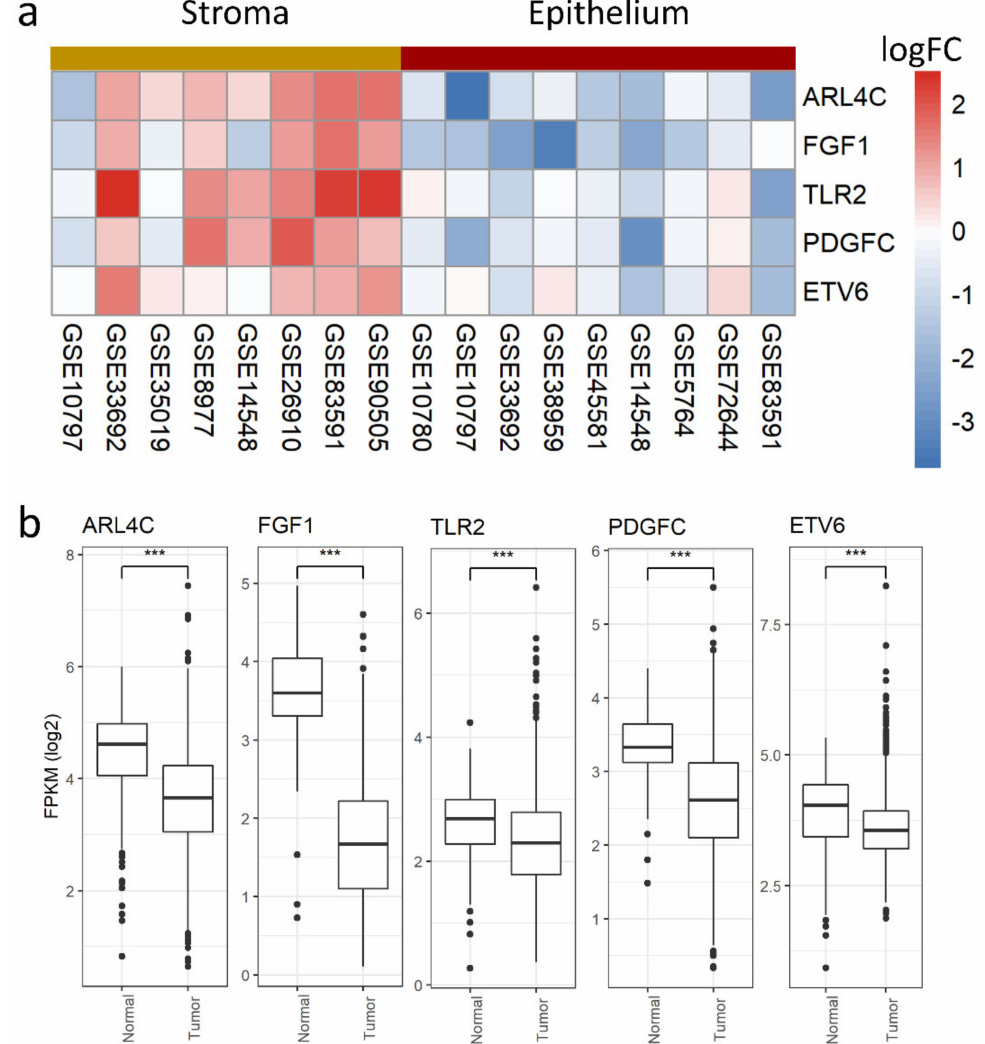
Figure 4. The opposite regulation of genes in tumor stroma or epithelium is hidden in bulk samples. ( a ) Top five significantly differentially expressed genes with higher expression in tumor stroma and lower expression in tumor epithelium when compared to respective compartments in normal breast tissue. Rows correspond to the five selected genes and columns to GEO IDs of datasets where the comparisons were possible and that were merged in the meta-analysis. On the left, datasets comparing normal and tumor stroma are shown, while on the right, there are datasets comparing normal and tumor epithelium. The color in the heatmap indicates logFC value for the corresponding gene and dataset. ( b ) Gene expression changes detected in bulk samples from the TCGA dataset for the five selected genes tested with the Wilcoxon test (*** p <